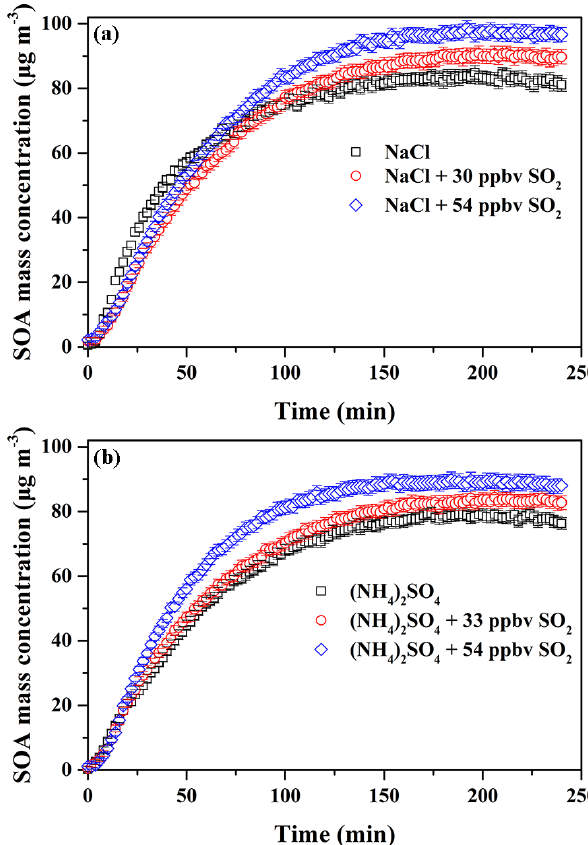
Figure 8. Time-dependent growth curves of SOA mass concentra- tion for guaiacol photooxidation in the presence of SO 2 and inor- ganic seed particles ( a NaCl; b ( NH 4 ) 2 SO 4 ) (Exps. 4–9 in Table